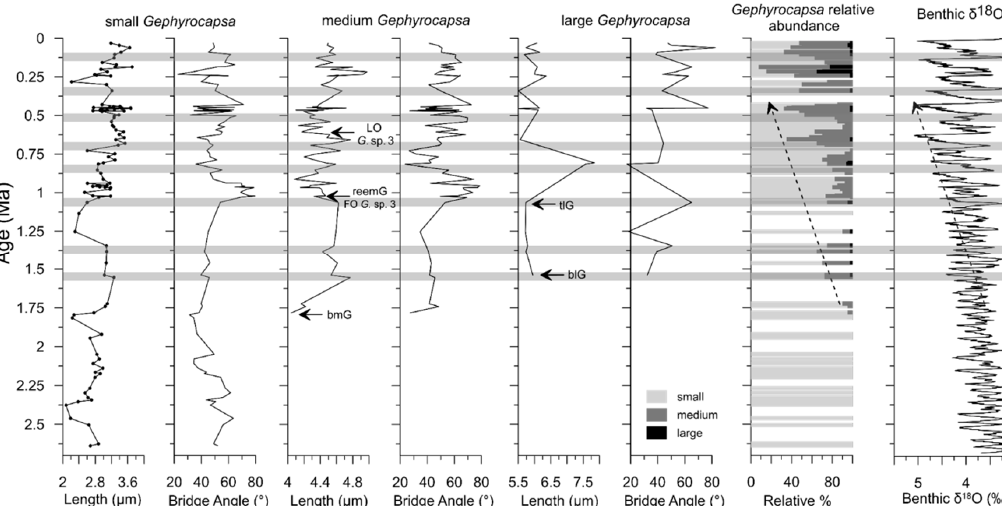
Figure 6. Size measurements of Gephyrocapsa from Site U1431D correlated with the LR04 Stack of [2]. Dots in the leftmost line graph are sample points. Gray bars highlight onsets of relative abundance peaks in medium Gephyrocapsa forms. Blank intervals in the relative abundance graph indicate barren samples. The age of each sample was calculated through linear interpolation of data points following the results of nannofossil biostratigraphy. The dashed arrows in the relative abundance graph and